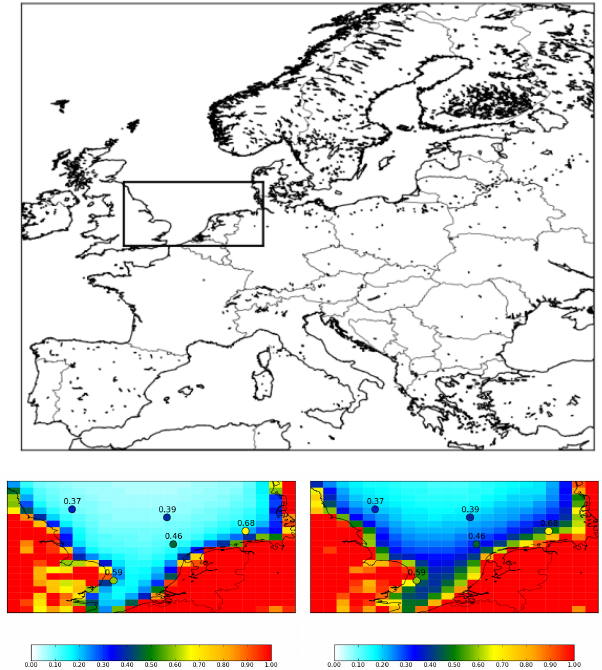
Figure 13. The yearly mean NH 3 concentrations as calculated by the LOTOS-EUROS model with the 'DEPACold' (left) and 'DEPAC3.11' module (right) for the year 2007 zoomed in on the North Sea the LOTOS-EUROS model with the DEPACold (left) and DE- and focusing on the lower concentration range between 0 and 1 µg m -3 . The median concentrations of the measurement campaign are displayed as numbers in the modeled distributions. The grid PAC3.11 module (right) for the year 2007 zoomed in on the North resolution of the model results is 0.50° longitude x 0.25° latitude (~28x28 km 2 ). Sea and focusing on the lower concentration range between 0 and 1µgm − 3 . The median concentrations of the measurement cam- paign are displayed as numbers in the modeled distributions. The grid resolution of the model results is 0.50 ◦ longitude × 0.25 ◦ lati- tude ( ∼ 28 × 28km 2 )